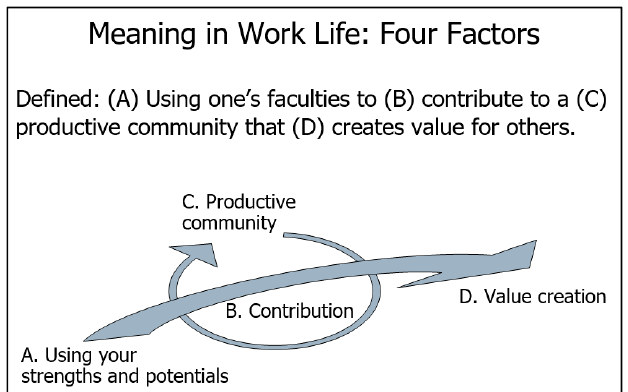
Figure 1. Meaning in Work Life: Four Factors [20,21]. A: Every person has a unique set of potential and signature strengths, and when actualising their potential, the meaning is produced. B: When making your contribution using the potential that is relevant to others, you can make a difference in the world. This difference produces meaning. C: Participating in a productive community or being a part of a group that accomplishes something important is experienced as meaningful. D: The identification of a need and helping to meet that need creates value for others, which, in turn, produces meaning [20–24].